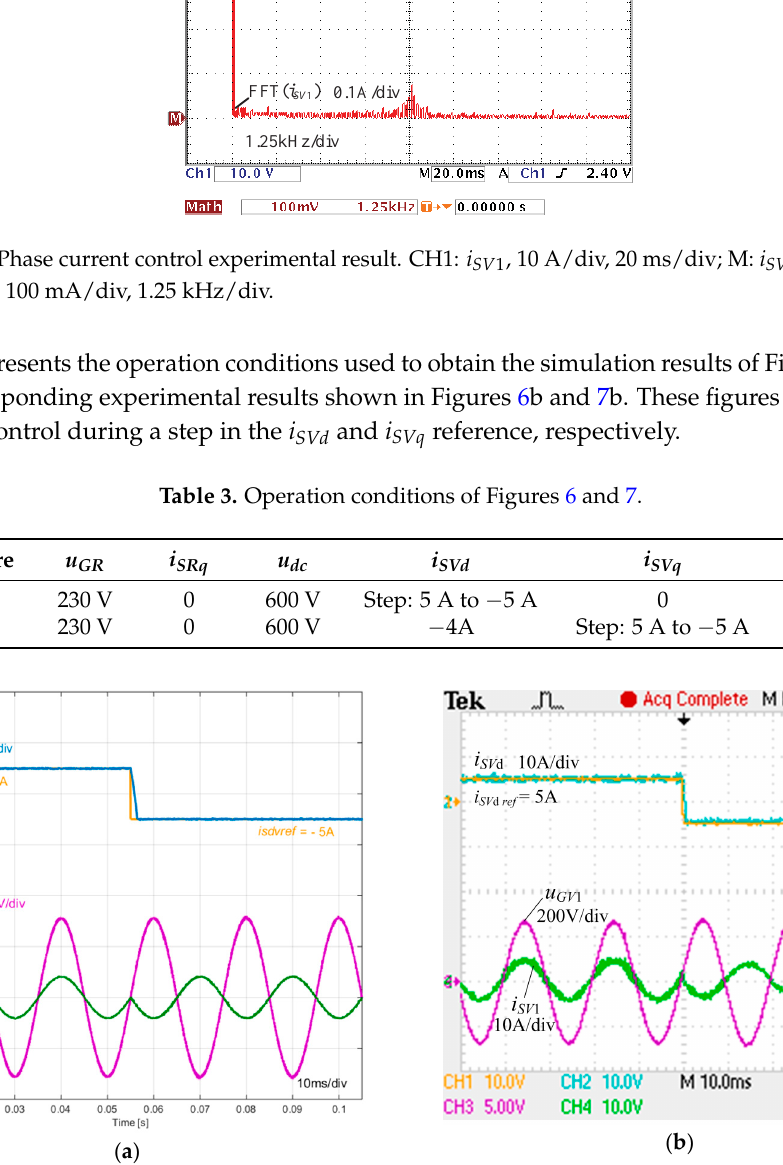
Figure 6. Phase current control: ( a ) Simulation result, CH1: i SVdref , 10 A/div; CH2: i SVd , 10 A/div; CH3: u GV 1 , 200 V/div; CH4: i SV 1 , 10 A/div; 10 ms/div; ( b ) Experimental result, CH1: i SVdref , 10 A/div; CH2: i SVd , 10 A/div; CH3: u GV 1 , 200 V/div; CH4: i SV 1 , 10 A/div; 10 ms/div.